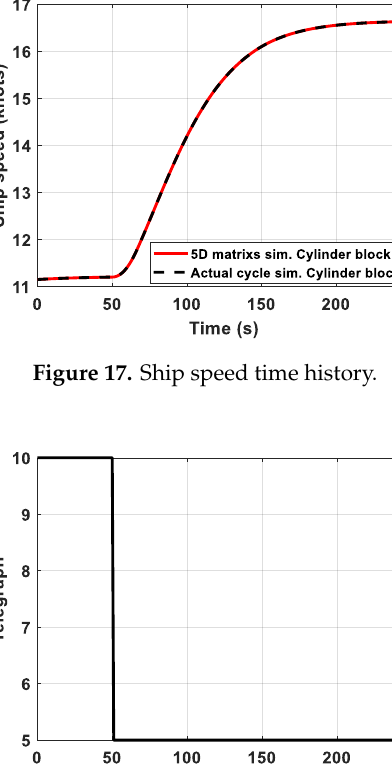
Figure 18. Lever position in deceleration manoeuvre.